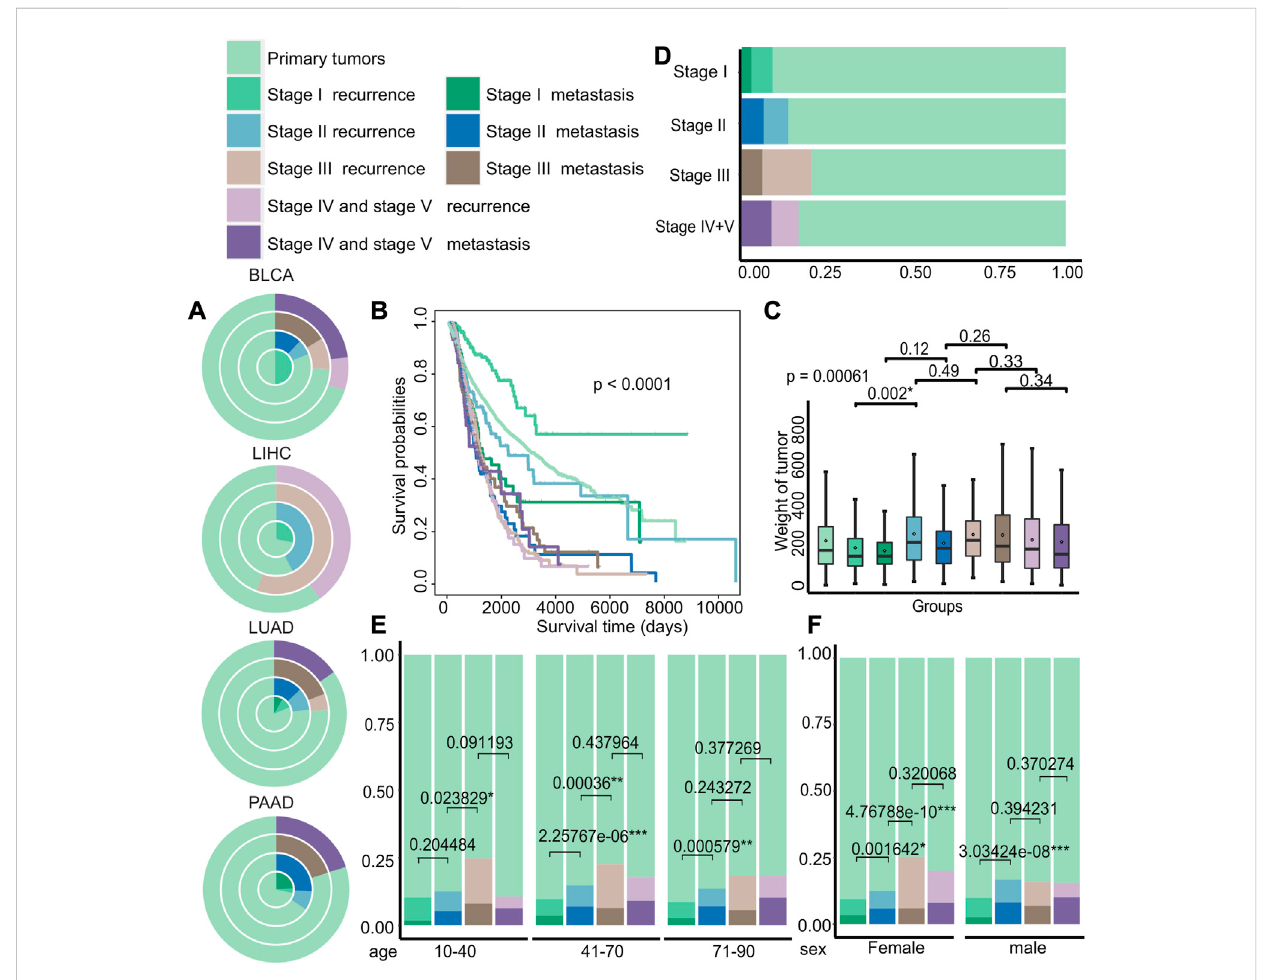
Differences in the clinical characteristics of cancer patients with primary tumors, recurrent tumors, and metastatic tumors. (A) The distribution of cancer patients with primary tumors, recurrent tumors, and metastatic tumors in BLCA, LIHC, LUAD, and PAAD in each stage. Each circle from the inside totheoutsidewerestagesI,II,III,andIV+V. (B – C) Kaplan – Meiersurvivalcurvesandtumorweight. (G) Boxplotofpatientswithprimarytumors,recurrent tumors, and metastatic tumors in various stages. (D – F) Distribution histograms on age and gender of patients with primary tumors, recurrent tumors, andmetastatic tumorson variousstages ofcancer. The age groups weredivided into young adultsaged10 to 40, middle-agedadultsaged41 to 70, and older adults aged 71 to